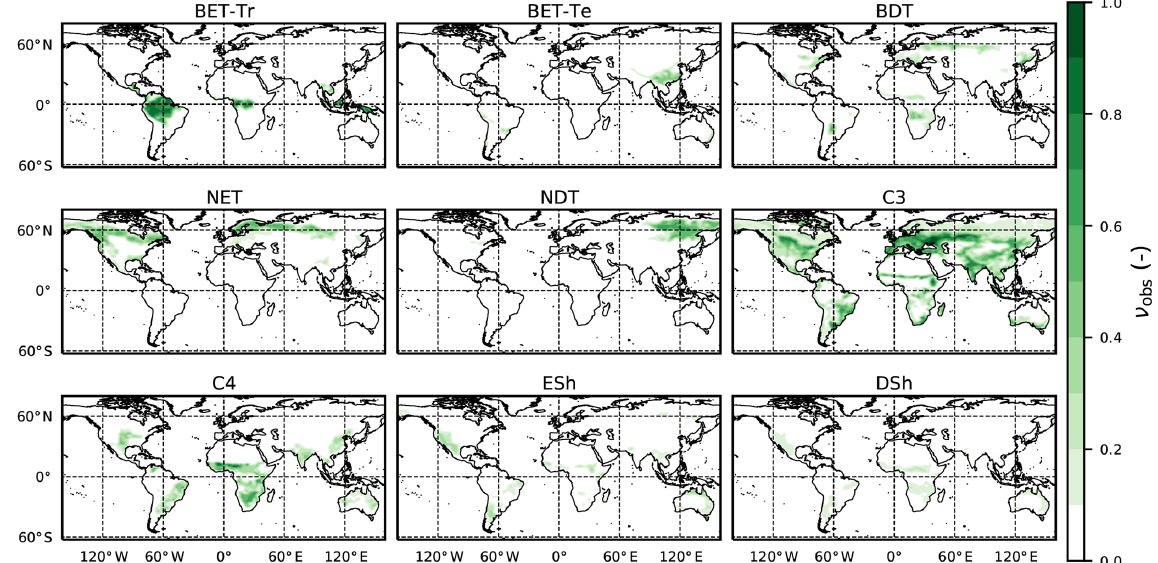
Figure 3. Observation-based dataset of the PFT area fractions for the nine JULES PFTs (Harper et al., 2016) as listed in Table 3.